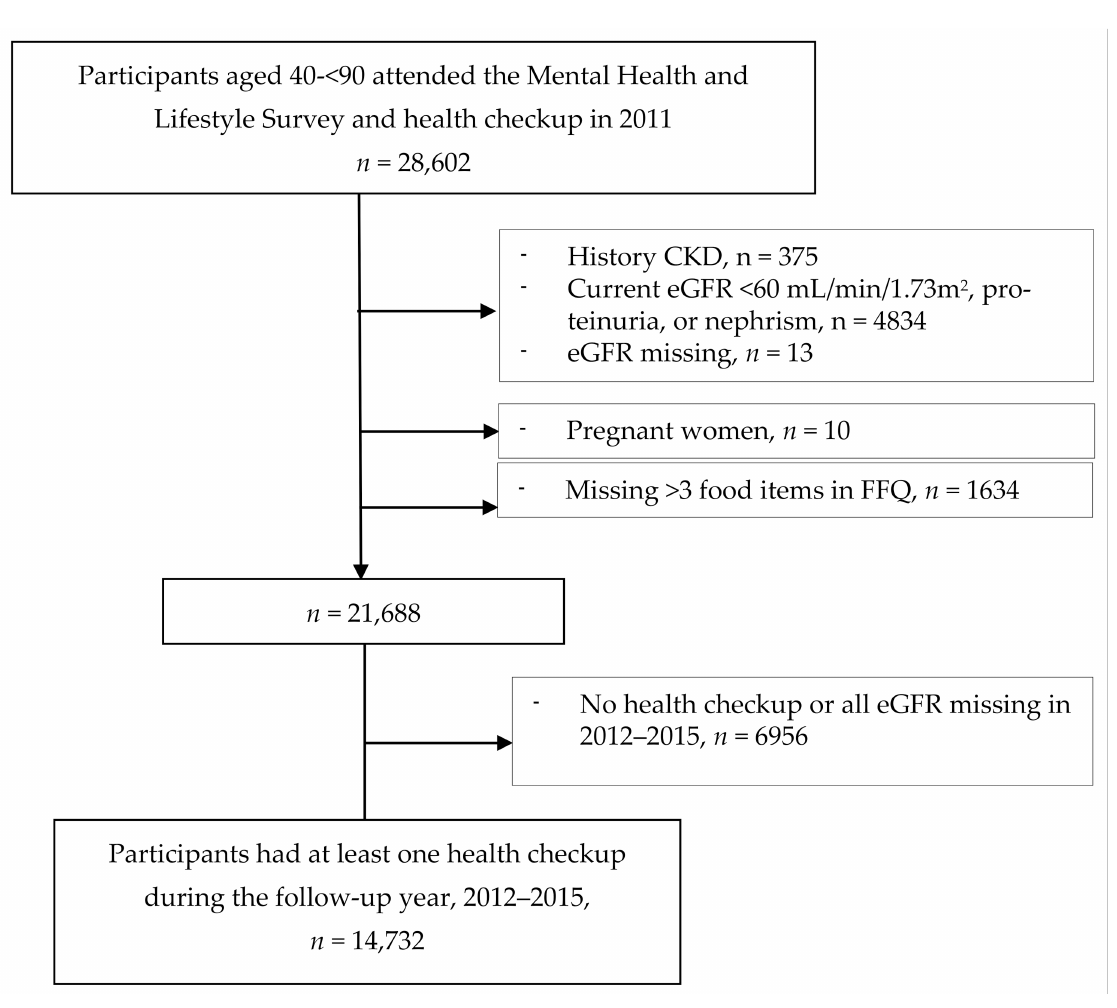
Figure 1. Flow diagram of study participants, Fukushima Health Management Survey, 2011–2015. CKD, chronic kidney disease; eGFR, estimated glomerular filtration rate; FFQ, food frequency